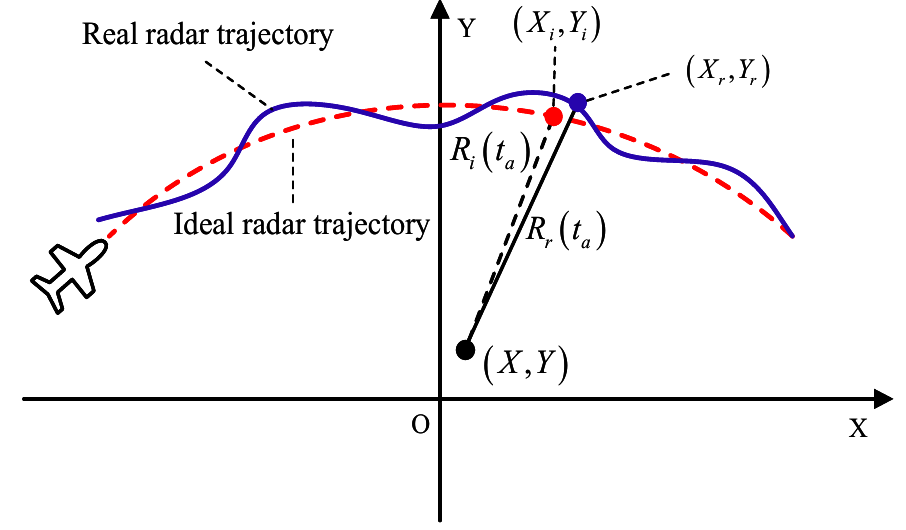
Figure 2. Schematic diagram of the motion error geometric model of a point